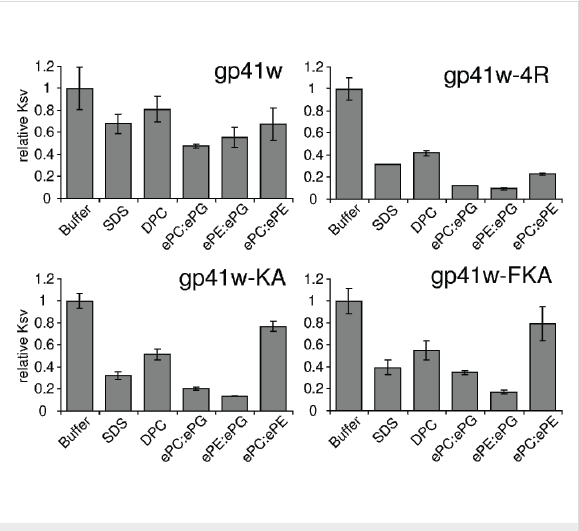
Figure 3: Relative K sv values calculated for gp41w, gp41w-4R, gp41w- KA and gp41w-FKA in buffer and in the presence of detergent micelles and phospholipid LUVs. Error bars represent the standard deviation of three separate trials. Values are reported as relative values compared to the K sv determined in buffer. The numerical values of the buffer K sv s were 10.3, 27.8, 16.4 and 17.9 for gp41w, gp41w-4R, gp41w-KA and gp41w-FKA,